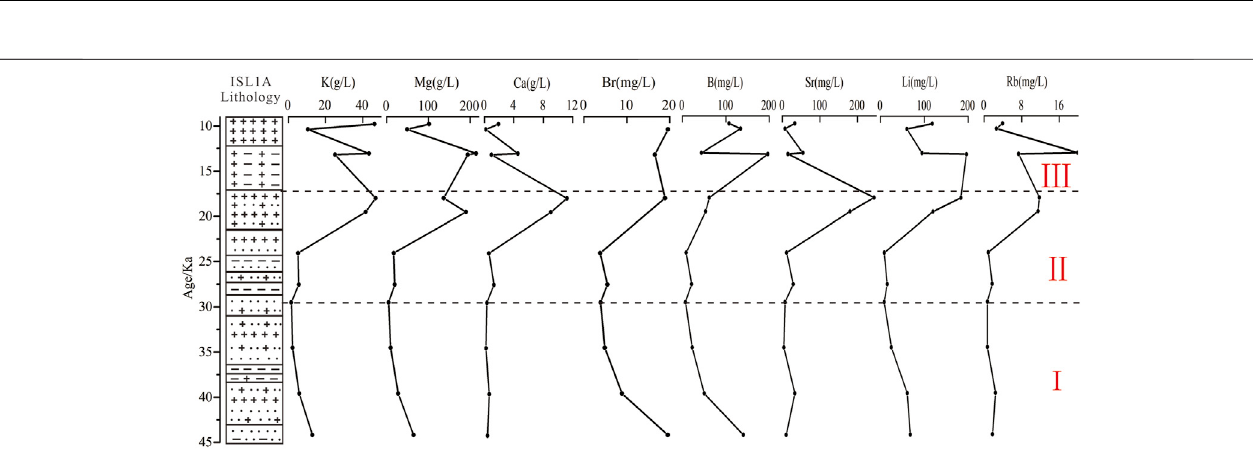
FIGURE 7 | Change characteristics about chemical composition of halite fl uid inclusions.